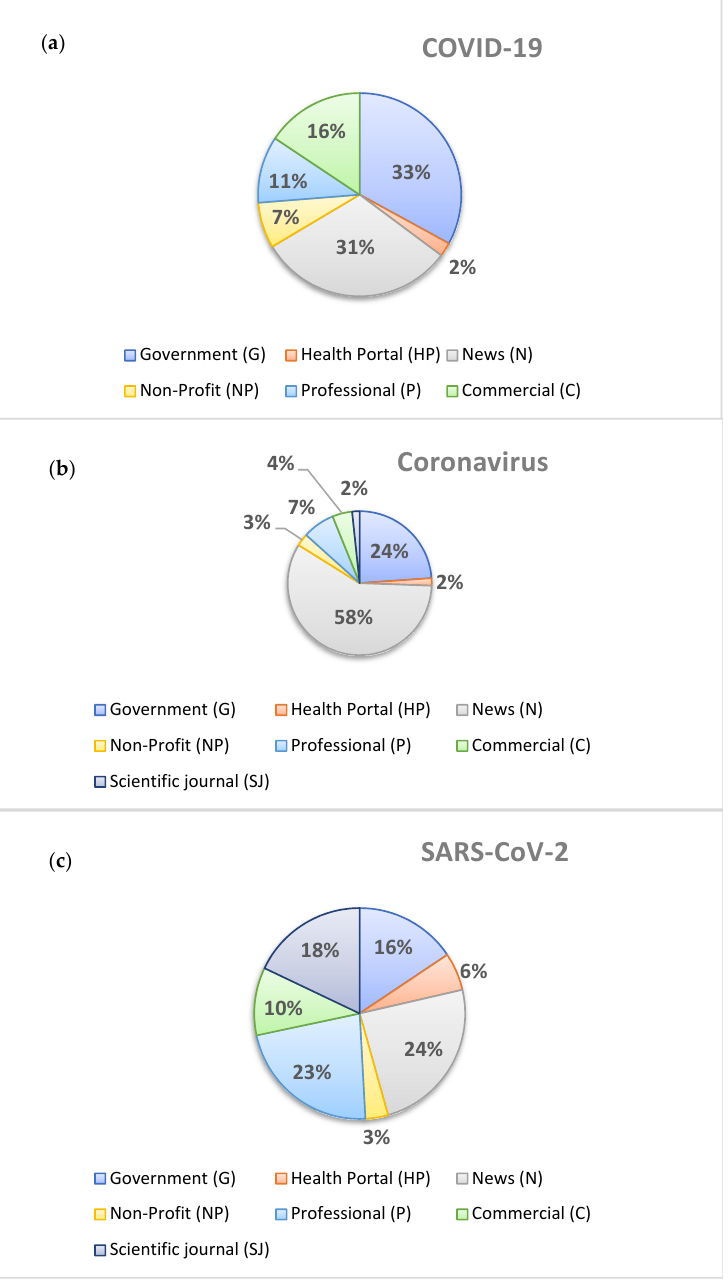
Figure 1. Frequency of key words on different types of webpages (all countries): ( a ) COVID-19; ( b ) Coronavirus; ( c ) SARS-CoV-2.